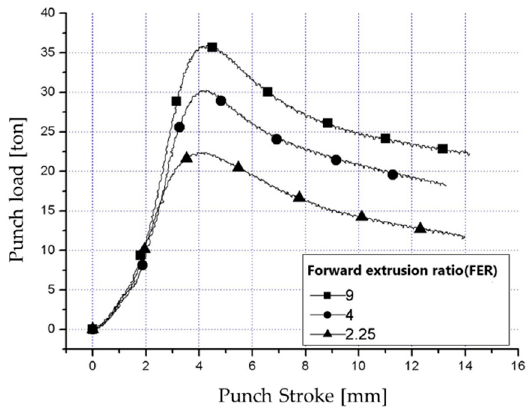
Figure 7. Variation of punch loads along the punch stroke. (Temperature = 200 °C, BER = 4.02, and punch speed = 20 mm/s).